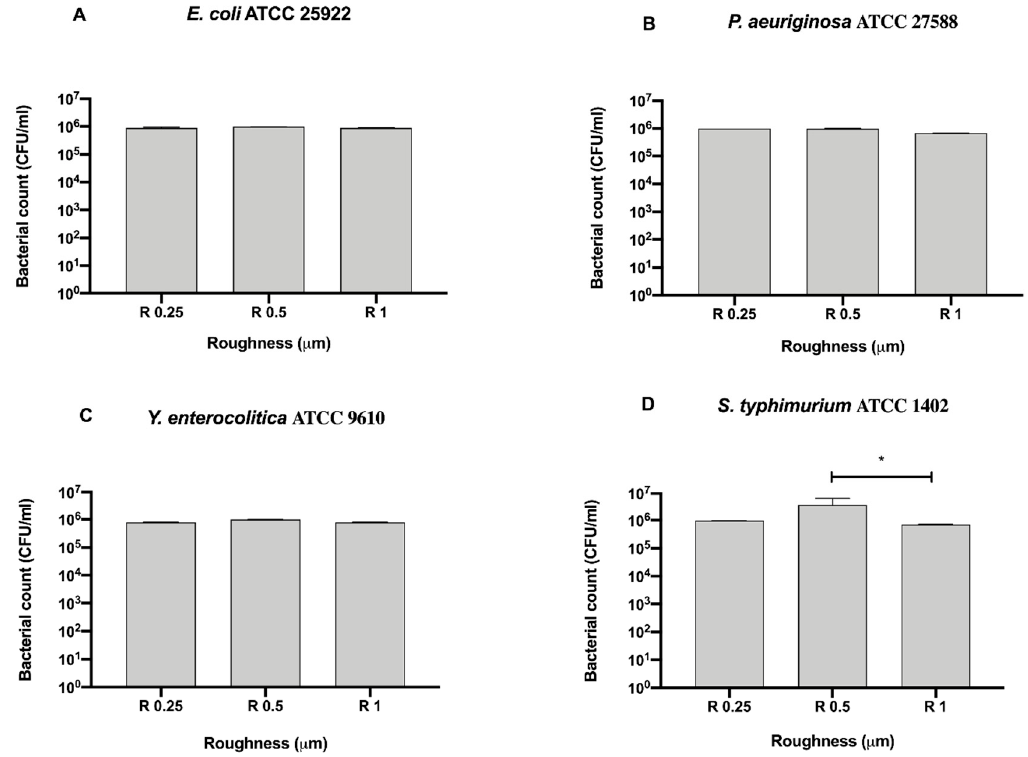
Figure 4. Antibacterial activity of di ff erent surface roughness against Gram-negative bacteria ( A ) E. coli ATCC 25922, ( B ) P. aeruginosa ATCC 27588, ( C ) S. typhimurium ATCC 1402 and ( D ) Y. enterocolitica ATCC 9610, * p < 0.05.